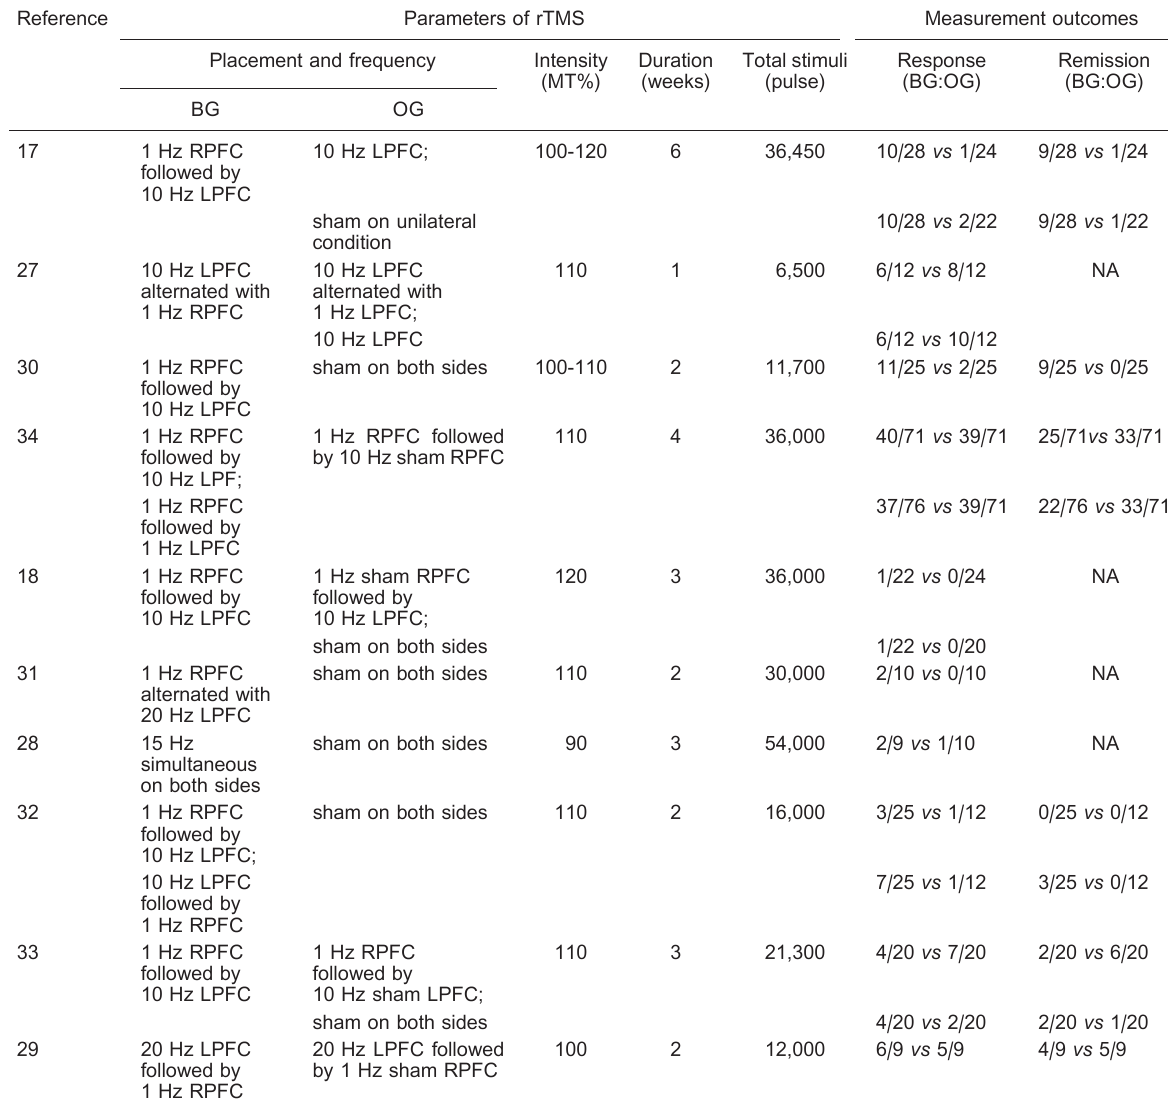
Table 3. Design characteristics of the included